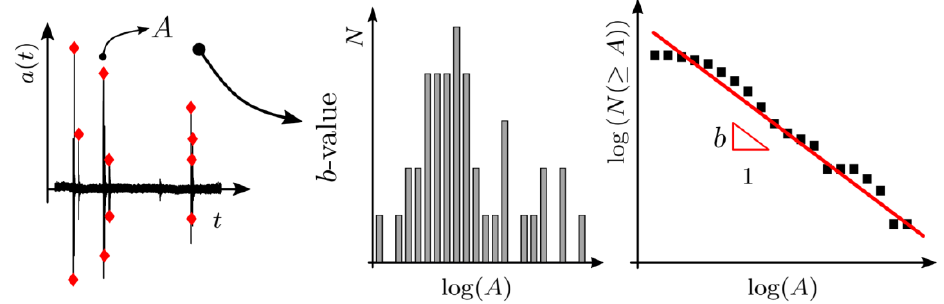
Figure 1. b -value parameter extraction from an event set.